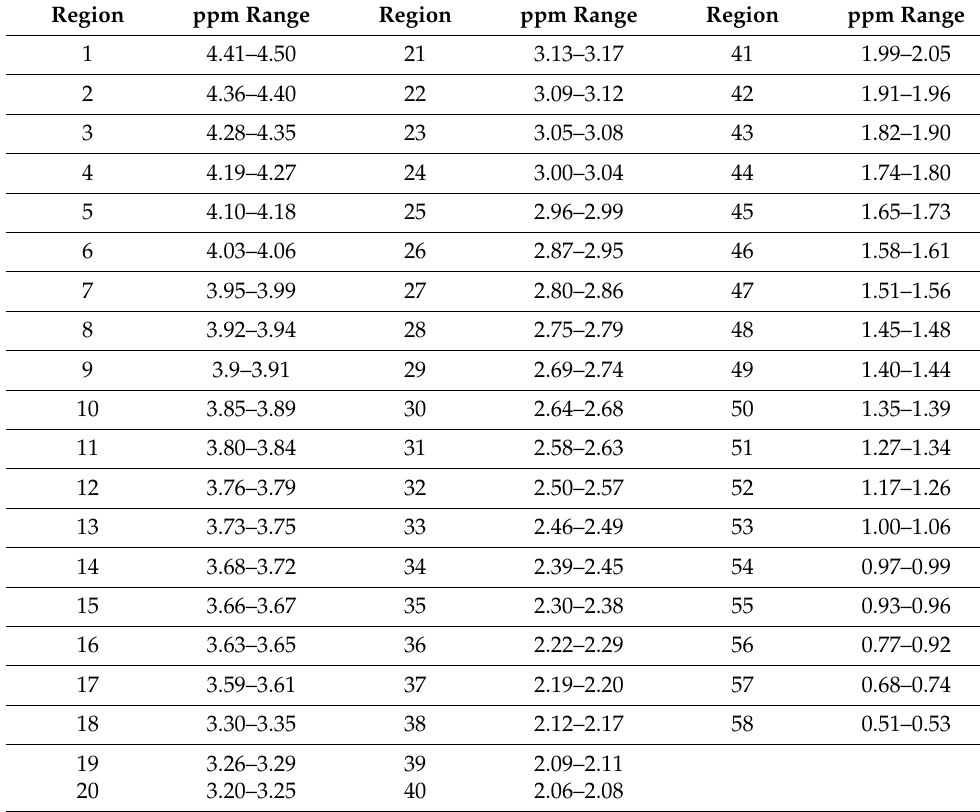
Table A1. Spectral regions 1 to 58 and their assigned ppm values.